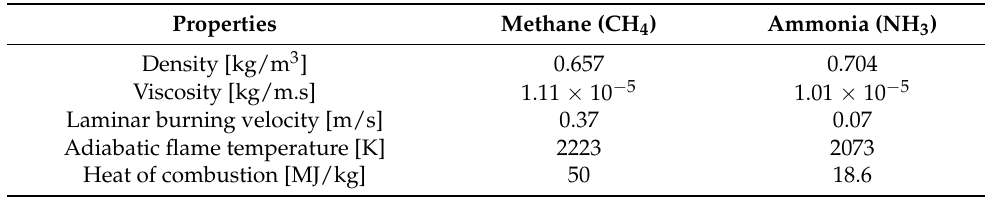
Table 1. Select physical and chemical properties of methane and ammonia at standard conditions T = 298 K and P = 1 atm [41].